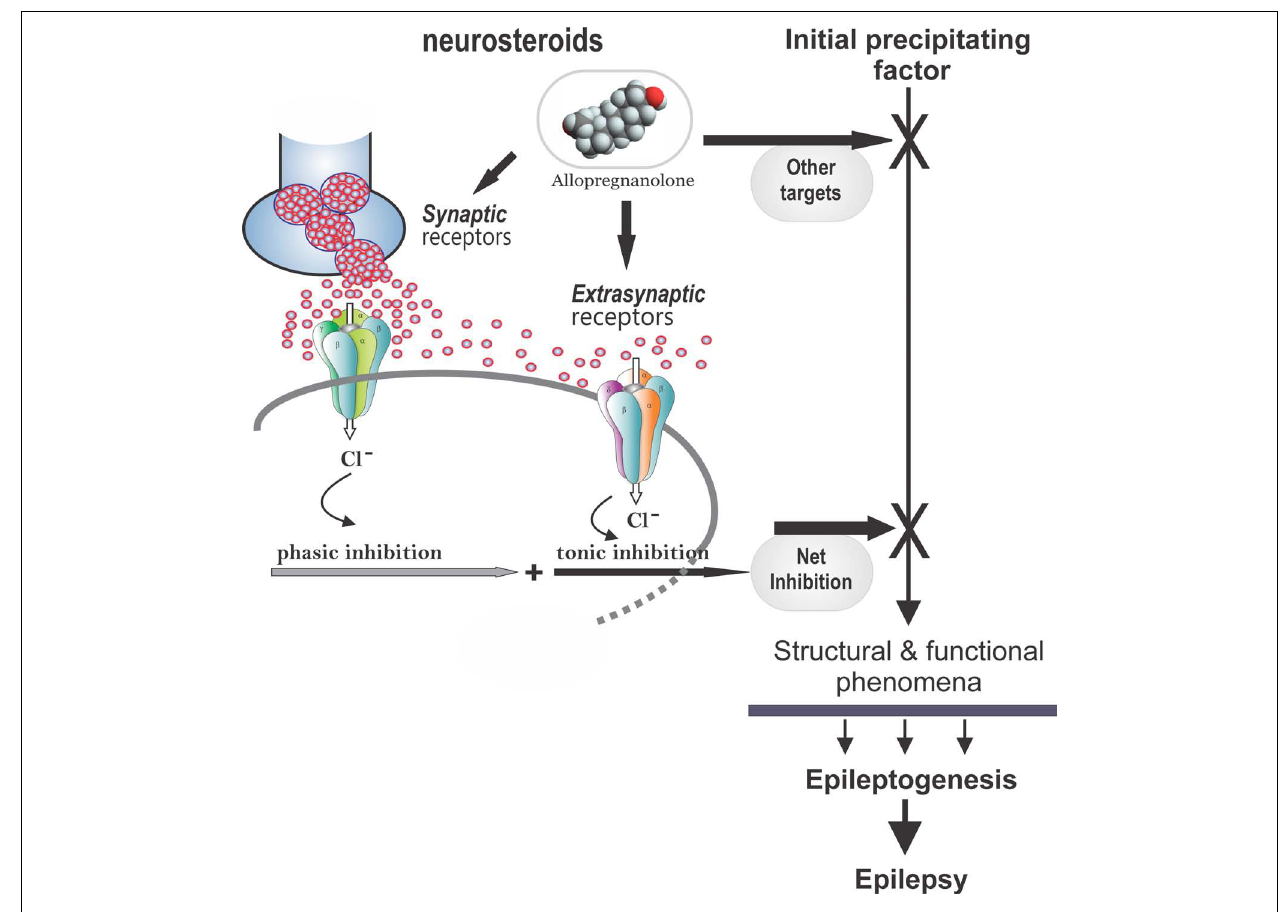
FIGURE 4 | Potential molecular mechanisms of neurosteroid interruption of epileptogenesis. In the brain, allopregnanolone and related neurosteroids may retard epileptogenesis by the interruption of one or more of the pathways leading to development of epilepsy, which generally occurs following an initial precipitating event. Neurosteroids